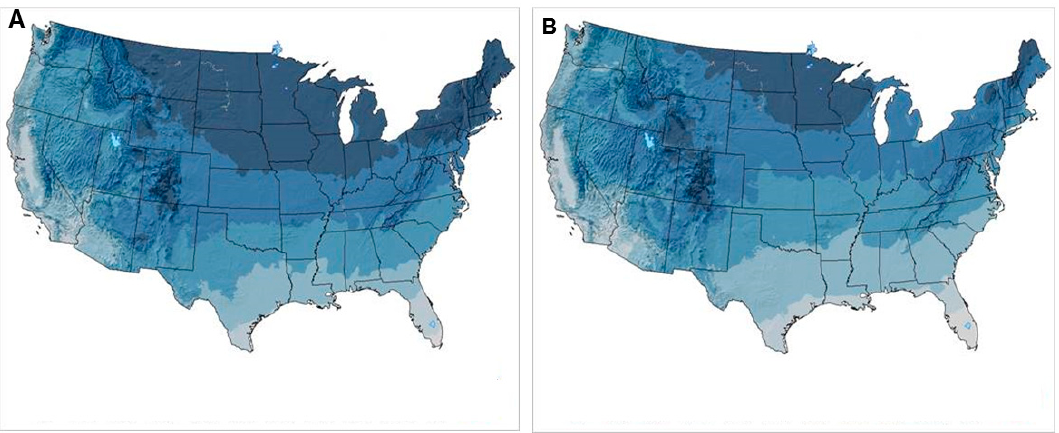
Figure 1. Maps showing the average minimum January temperatures (°F) in the continental United States: ( A ) 1970; ( B ) 2016. Dark Blue = –10 °F; medium blue = 11–20 °F; light blue = 21–30 °F; blue-green = 31–40 °F; gray = 41–50 °F. Photo credits Dr. R. Ryan Lash, Traveler’s Health Branch, DGMQ, Centers for Disease Control and Prevention, Atlanta, GA.